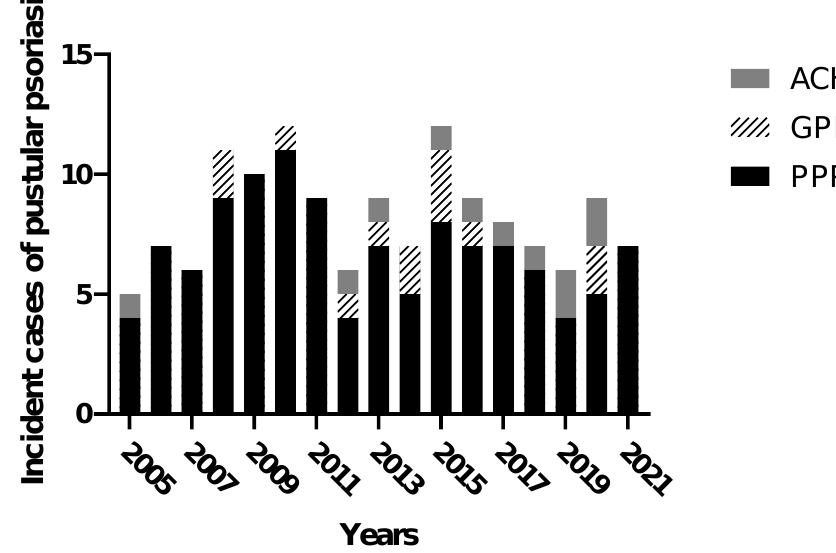
* Fisher’s exact test and the Kruskal – Wallis test for the categorical and unpaired non-normally dis- tributed quantitative data, respectively. 1:18.8 in 2010 to 1:67.0 in 2006.